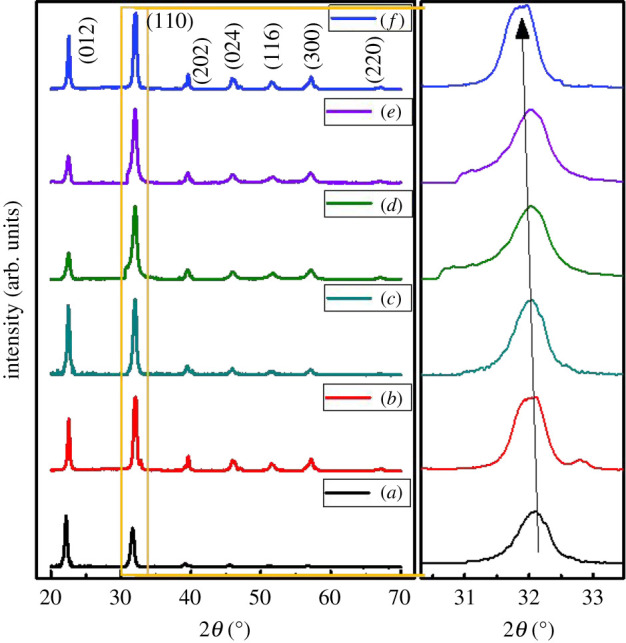
Indexed XRD patterns of the (a) pure BFO, (b) x = 0.00, (c) x = 0.03, (d) x = 0.05, (e) x = 0.07 and (f) x = 0.1 in BiFe0.9Co0.1−xNixO3.